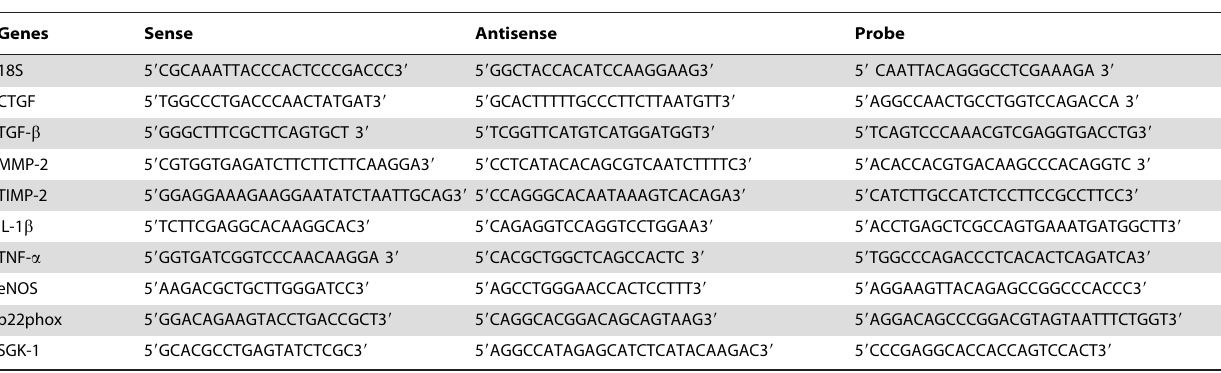
Table 1. Primers